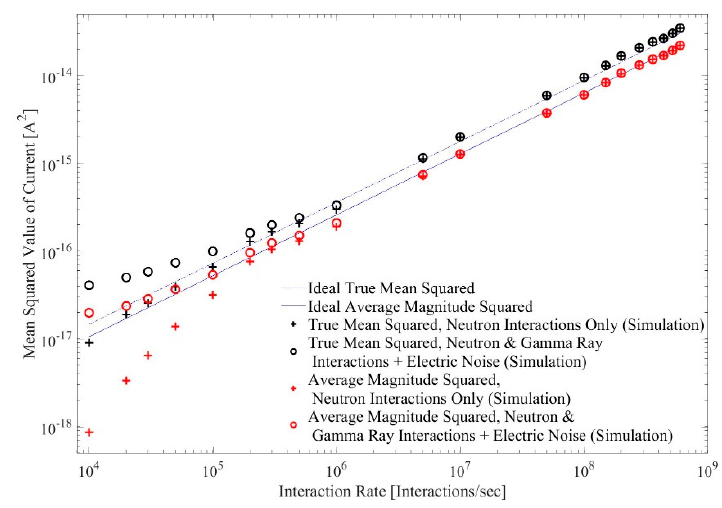
Figure 8. Comparison between true mean squared and averaged magnitude squared values.